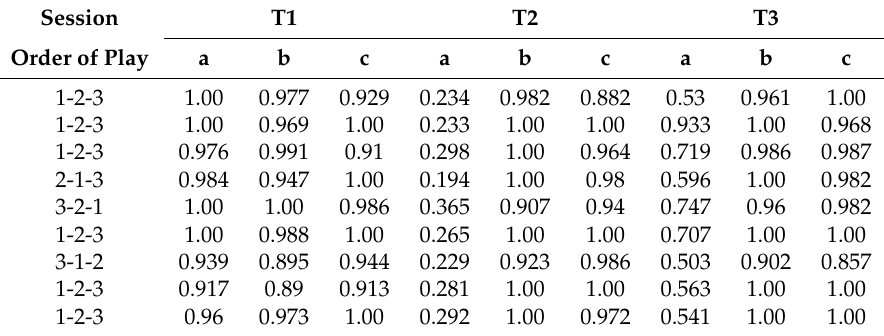
Table 4. Frequencies of informative/naive voting by type and treatment.